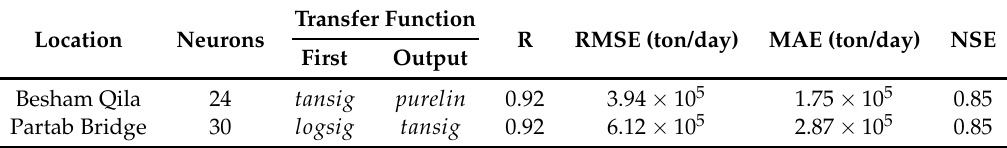
Table 3. Statistics of the best performing WA-ANN architectures for the Besham Qila and the Partab Bridge